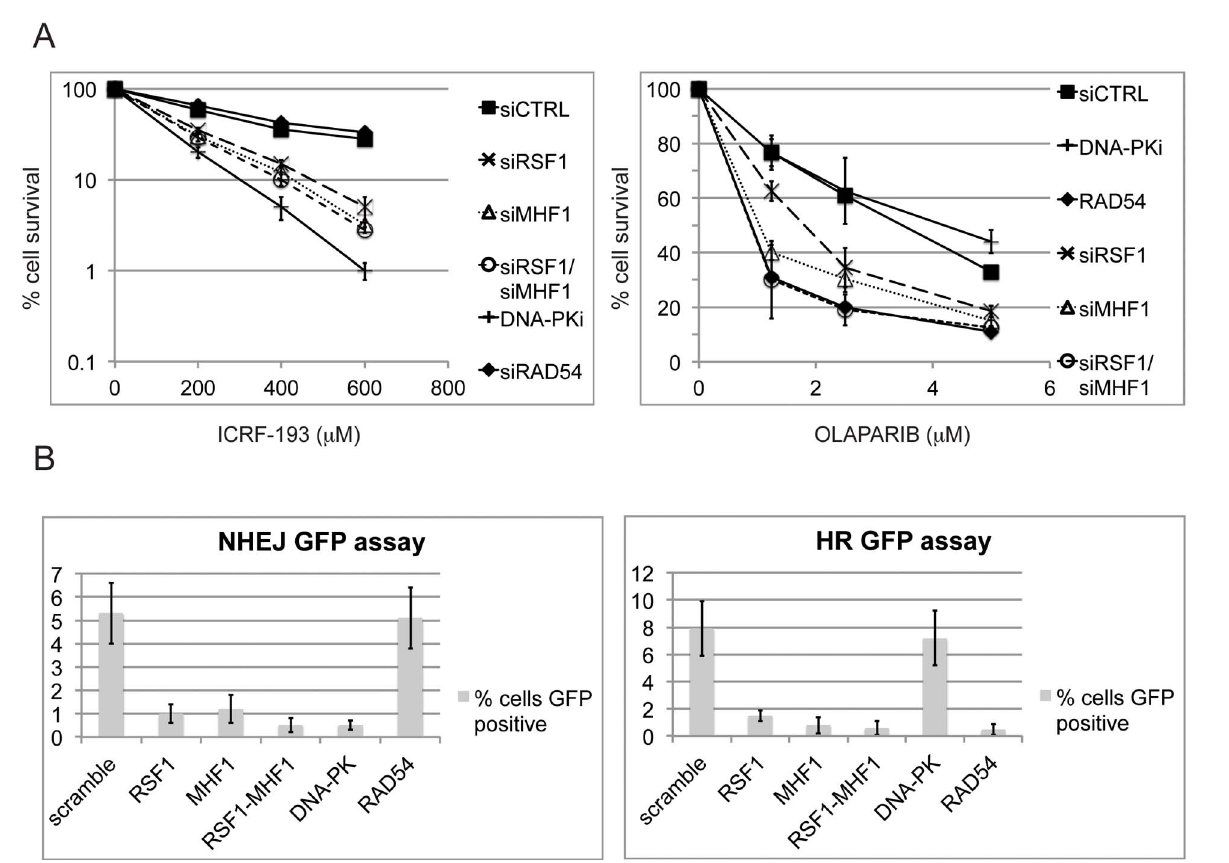
Figure 5. Recruitment of CENPS/MHF1–CENPX/MHF2 by RSF1 is an early event required for both NHEJ and HR. (A) Clonogenic survival after the indicated treatments of U2OS cells with ICRF-193 or Olaparib. (B) NHEJ and HR repair assays. Cell lines with stably integrated constructs specific for either NHEJ or HR were transfected with a plasmid that expresses the I-SceI endonuclease and with the indicated siRNAs. Cut sites and the EGFP gene have been transfected with a plasmid expressing the enzyme. Efficiency of reconstitution of the EGFP gene (measured by EGFP expression) is indicated. In both (A) and (B) error bars are the standard error of the mean (SEM) from three repetitions.